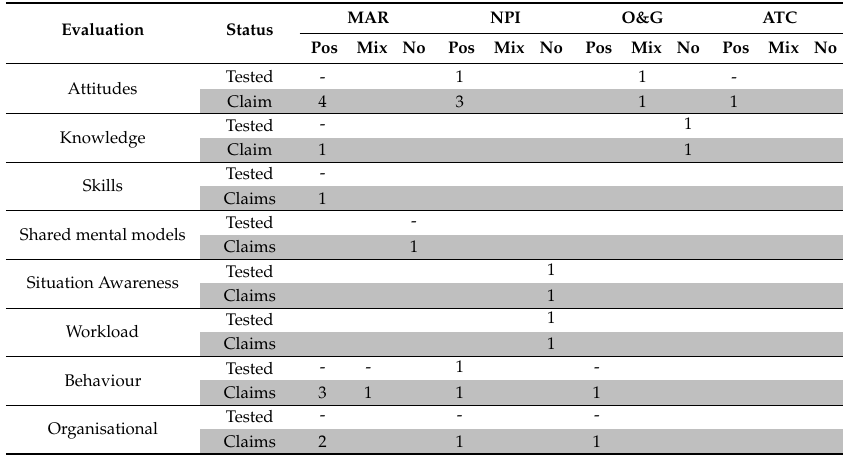
Table 7. Summary of evaluation claims and